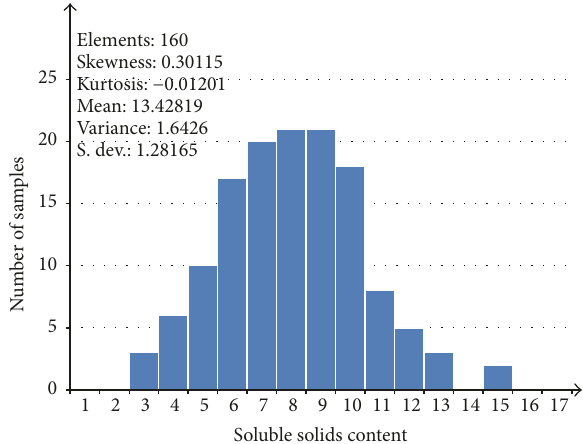
Figure 3: Distribution of soluble solids content of all 160 fruit samples.